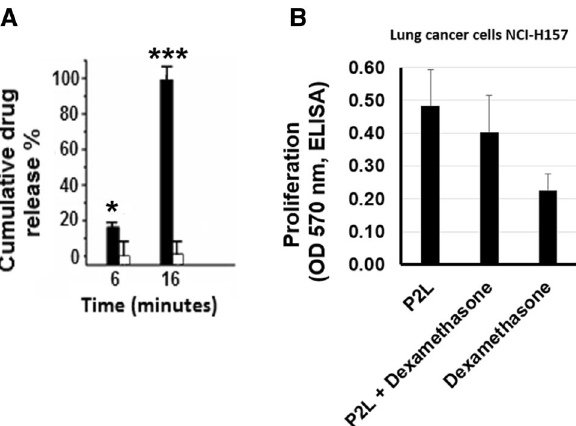
Figure 12. Dexamethasone release after 6 and 16 min in the presence (black bars) and absence (white bars) of electrical stimulation using UV–Vis spectroscopy (n = 3) ( A ). Lung cancer cells NCI-H157 were exposed to P2L, dexamethasone encapsulated in P2L (P2L+ Dexamethasone) and dexamethasone (3 µM) for 48 h, a trend towards decreased cells proliferation in P2L + Dexamethasone (17% vs P2L, non-significant, n = 3) was observed. Dexamethasone alone significantly suppressed proliferation (p < 0.01), compared to P2L alone ( B ). *p < 0.05, ***p < 0.001.